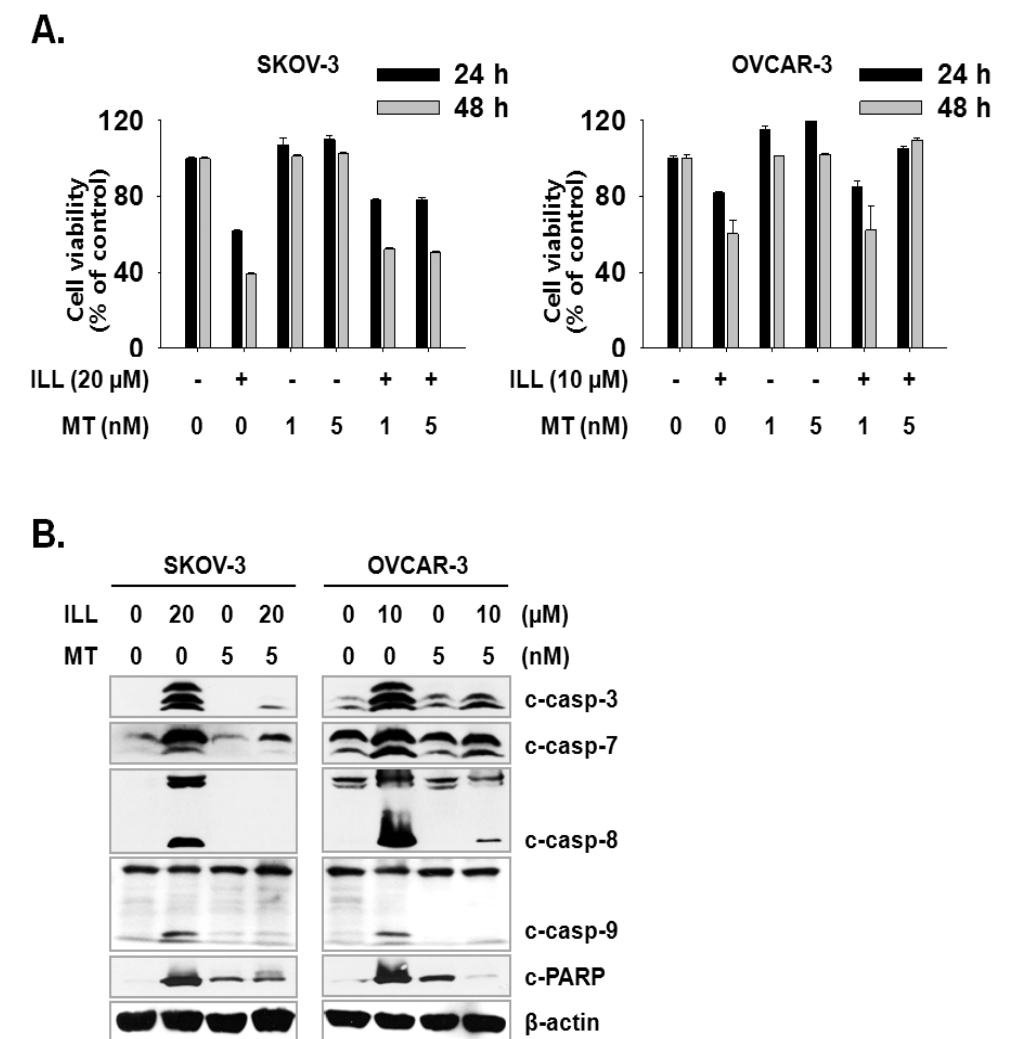
Figure 5. Amelioration of cell death by ILL using mtSO ‐ specific scavenger. ( A ) The pretreatment of Mito ‐ TEMPO rescued ILL ‐ induced cell death. Both cells were pretreated with 1 or 5 nM of Mito ‐ TEMPO for 3 h before 24 h or 48 h of ILL treatment. ( B ) Mito ‐ TEMPO prevented proteolytic activation of caspases and cleavage of PARP. The levels of each protein were detected by immunoblot. Values are the means ± SD for data in triplicate.